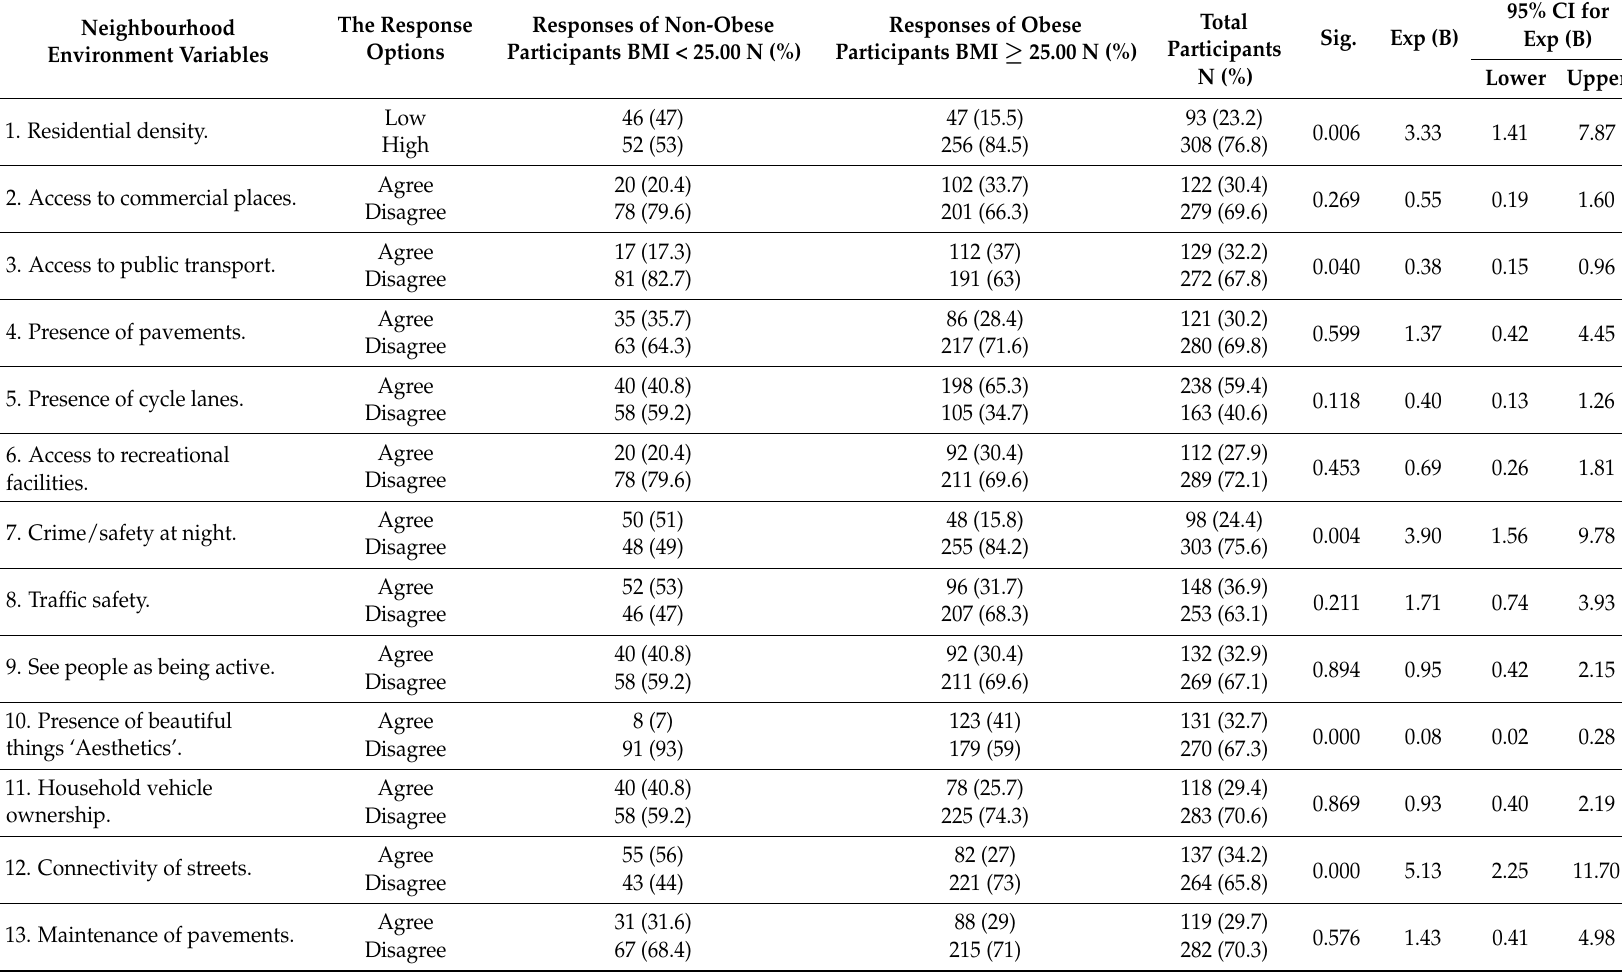
Table 3. Association between neighbourhood environment factors and BMI using binary logistic regression when sociodemographic and SES factors were adjusted *. Neighbourhood Environment